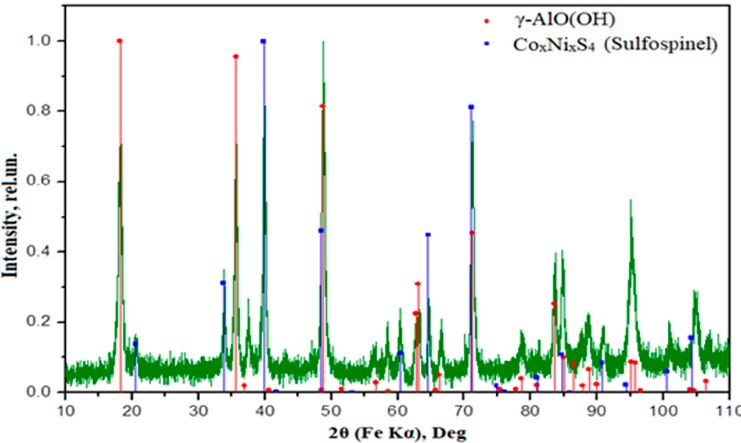
Figure 7. XRD patterns of the fresh catalysts and coke.